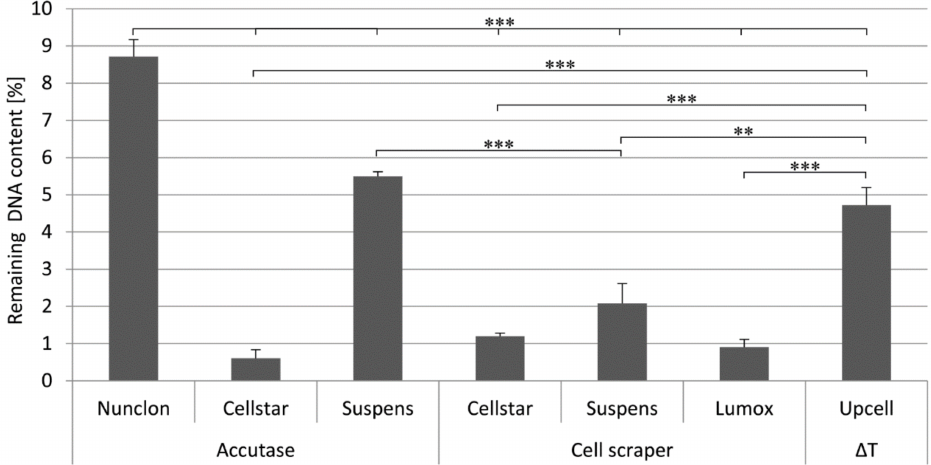
Figure 3. Remaining DNA content on different cultivation surfaces after different detachment procedures as determined by DNA measurement, ** indicate p < 0.01, and *** p <